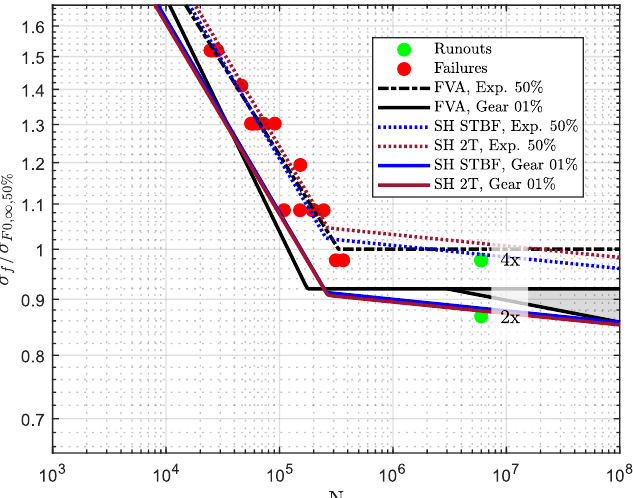
Figure 10. Comparison of two estimation methods for exemplary campaign A from experimental FZG database